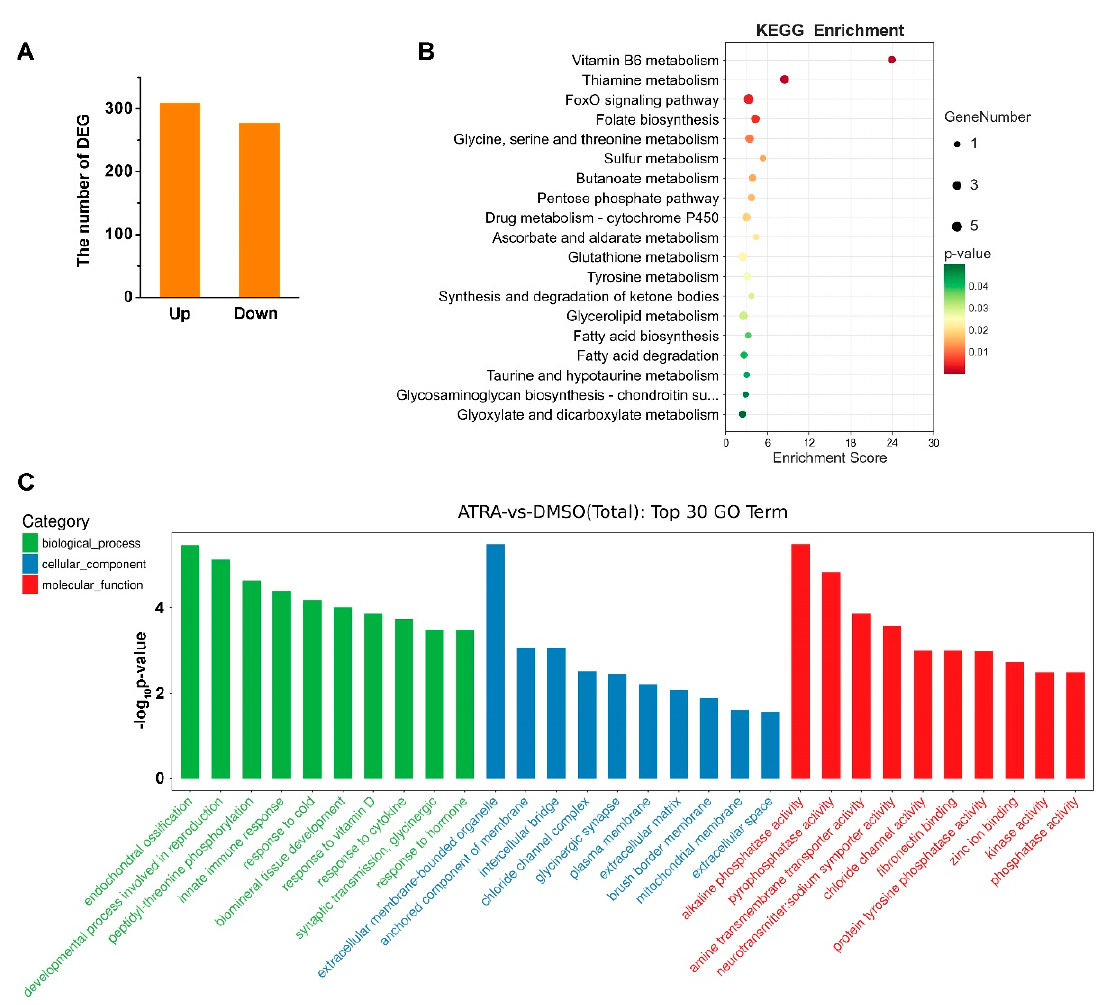
Figure 1. Transcriptome analysis of C. gigas after ATRA treatment. ( A ) Numbers of differentially expressed genes (DEGs) in C. gigas after all-trans retinoic acid (ATRA) treatment. Fold change ≥ 2, p values < 0.05. ( B ) KEGG pathways enriched for the ATRA-regulated genes. p values < 0.05. ( C ) GO enrichment analysis of DEGs in ATRA-treated oysters. p values < 0.05.